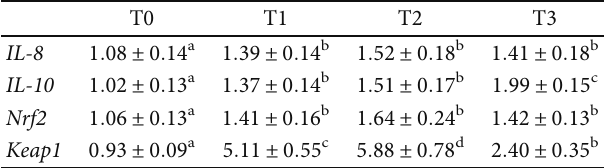
Figure 2: Hindgut morphology of grass carp fed semipuri fi ed diets. (a) the hindgut morphology of T0; (b) the hindgut morphology of T1; (c) the hindgut morphology of T2; (d) the hindgut morphology of T3. Table 8: Reactions of mRNA gene expressions in hindgut of grass carp fed semipuri fi ed diets ( means ± SD , n = 4